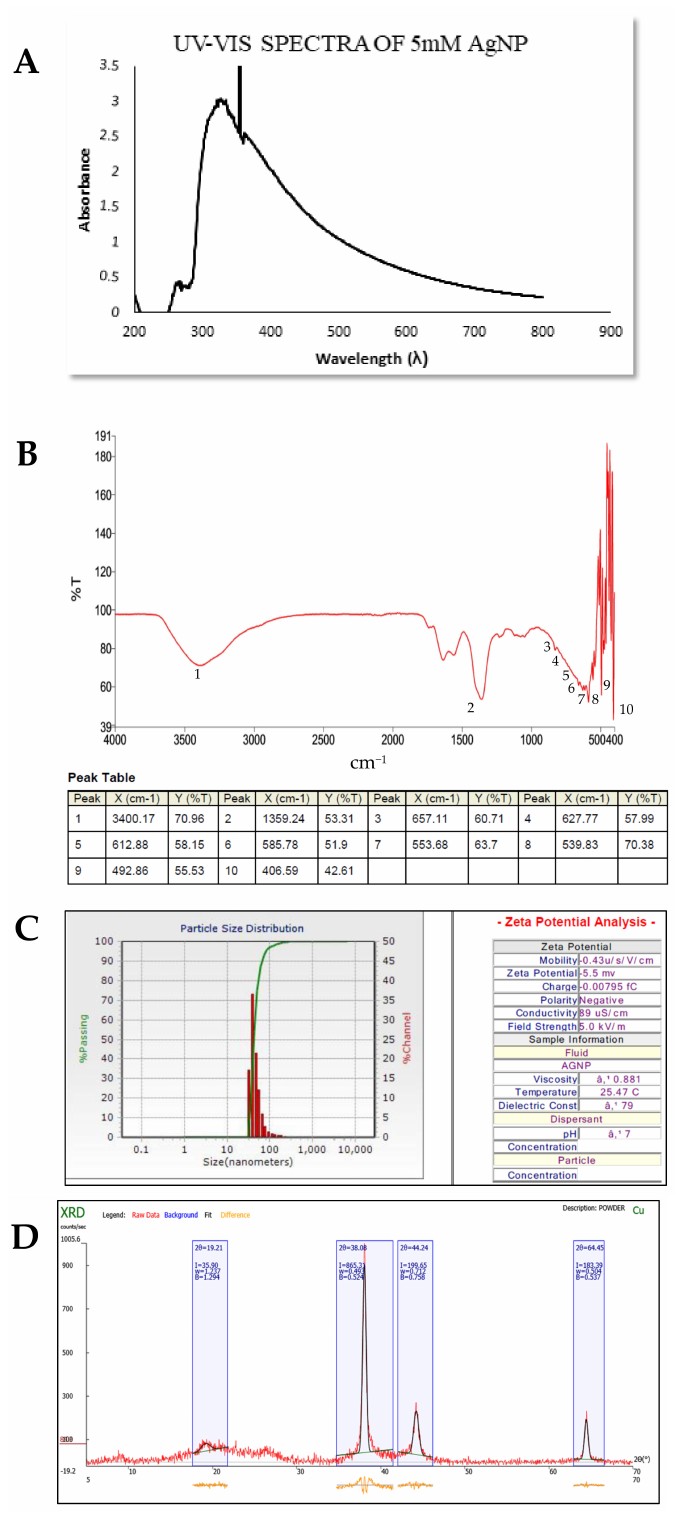
Figure 3. ( A ) UV–Visible spectroscopy of AgNPs showing peaks between 300 and 400 nm. ( B ) FTIR spectrum of synthesized AgNPs. ( C ) Dynamic light scattering analysis of AgNPs with varying sizes. ( D ) XRD diffraction pattern of silver nanoparticles synthesized from endophytic bacteria from Terminalia